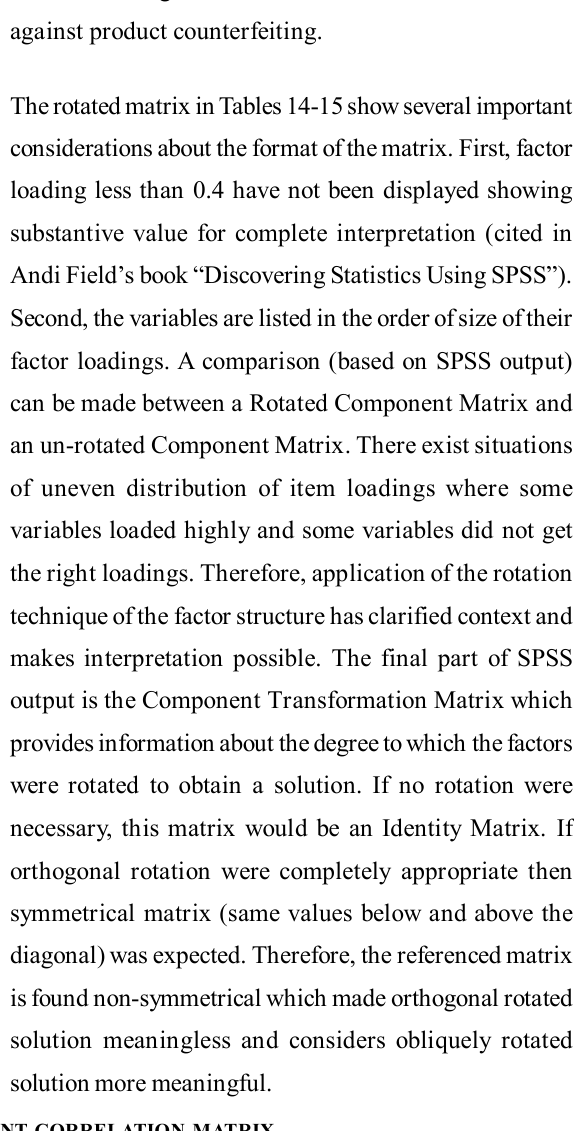
TABLE 13. DETAILS OF COMPONENT CORRELATION